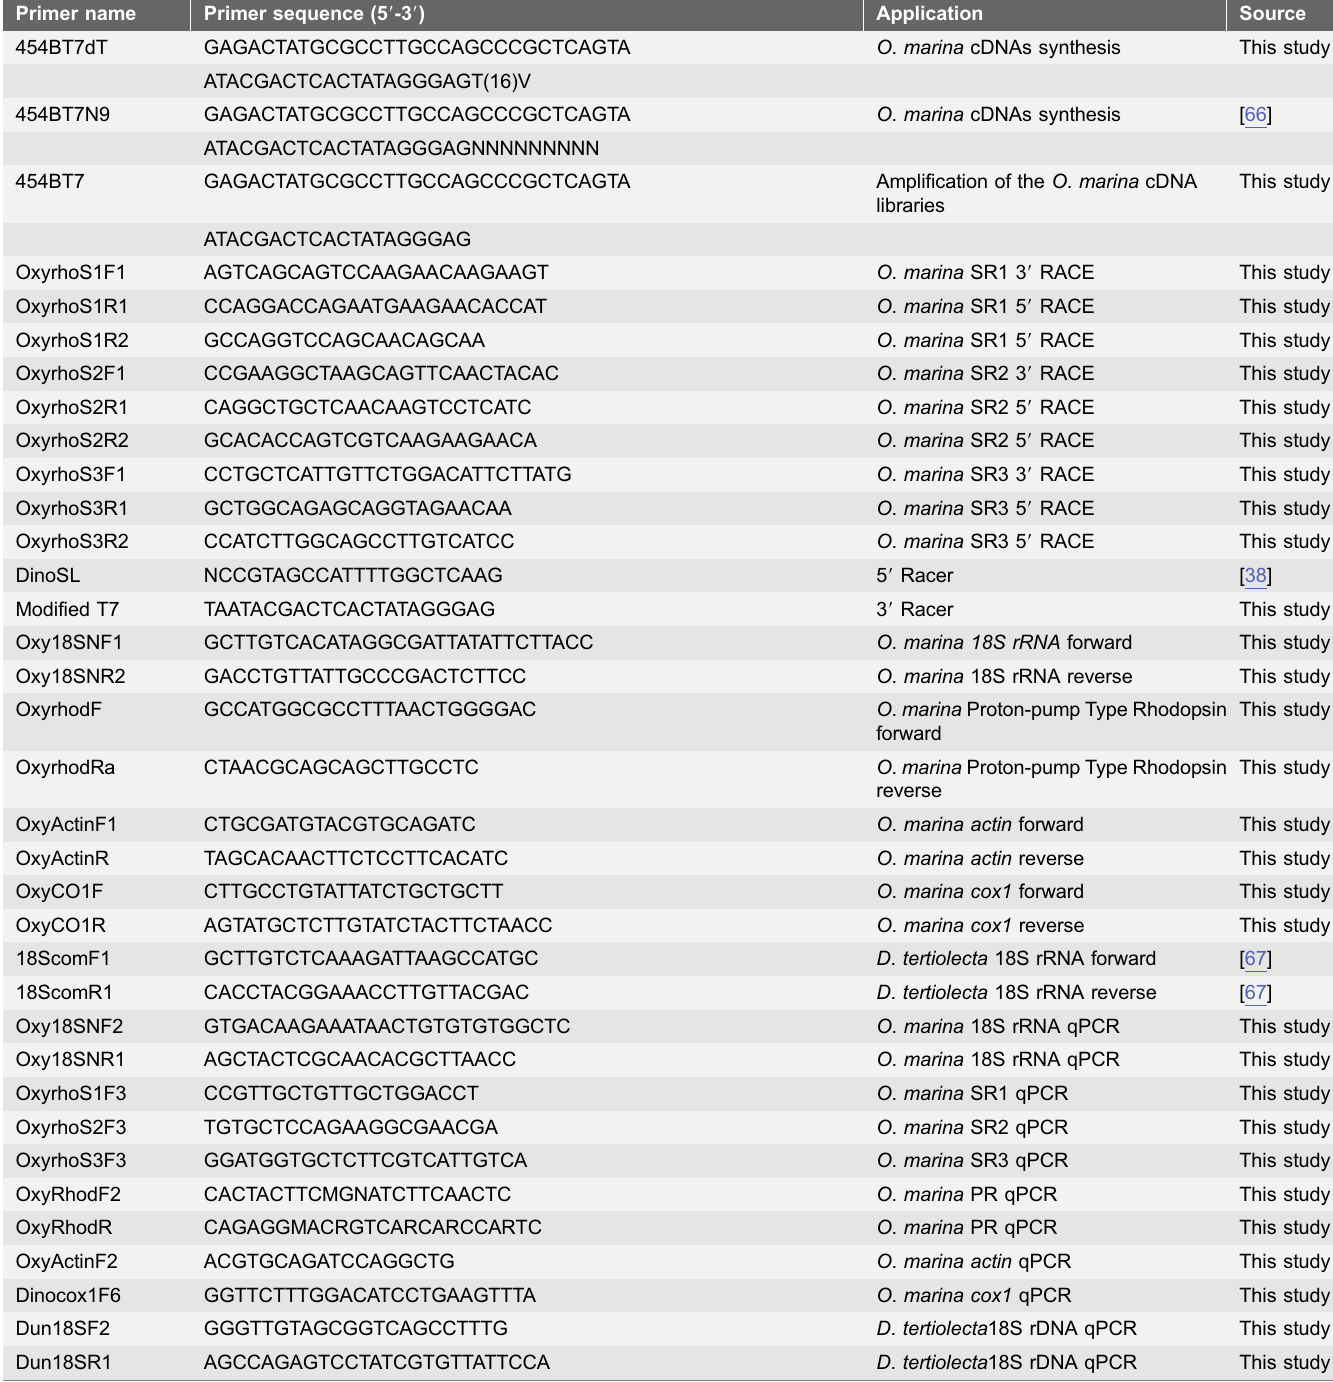
Table 1. Primers used in this study. Primer